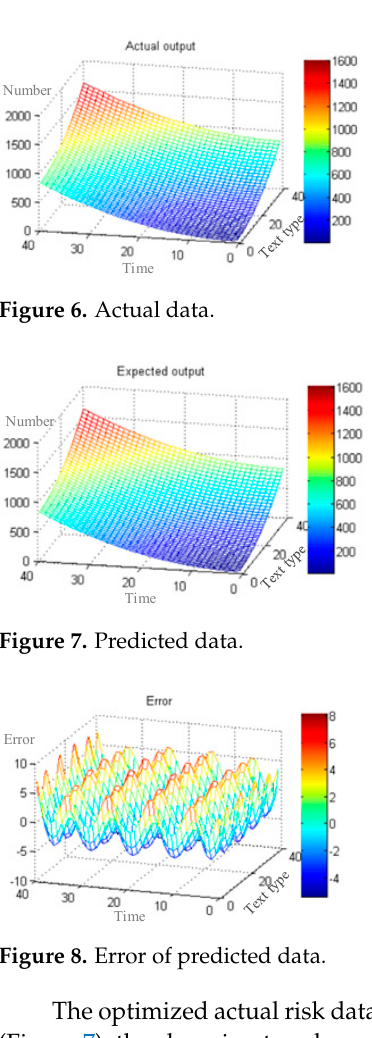
Figure 10. Error secondary optimization. The changing trend of the risk prediction data was the same as that of actual data, indicating that the secondary optimization of ANFIS did not affect the changing trend of the coal mine risk prediction. From Figure 10, the error was within 4, which was 66% lower than the original error and 60% lower than the first optimization. The analysis of the results of the two optimizations shows that the optimized ANFIS has good function approximation characteristics, fast convergence speed, and high precision, and can automatically form fuzzy reasoning rules and adjust learning parameters. 3.3. Early Warning Results In this paper, the CL, UCL, and LCL of the control chart can be drawn in days with reference to the number of hidden dangers and three-violations of coal mines within the first three years of the prediction time point. Three-violations refer to three types of violations made by coal mine workers, i.e., illegal command, illegal operation, and violation of labor discipline. The training samples and predicted values were the changing trends of the number of three-violations, as shown in Figure 11. The more three-violations, the higher the coal mine’s risk. From Figure 11, although three-violations exist, the number was within the UCL, indicating that the risk level of the coal mines in this period was within an acceptable range. In recent years, coal mine safety management achieved good results with no major risks or accidents, thus the coal mine safety is under control. In this paper, the statistical range of data was expanded to further explain the runaway phenomenon of control charts.